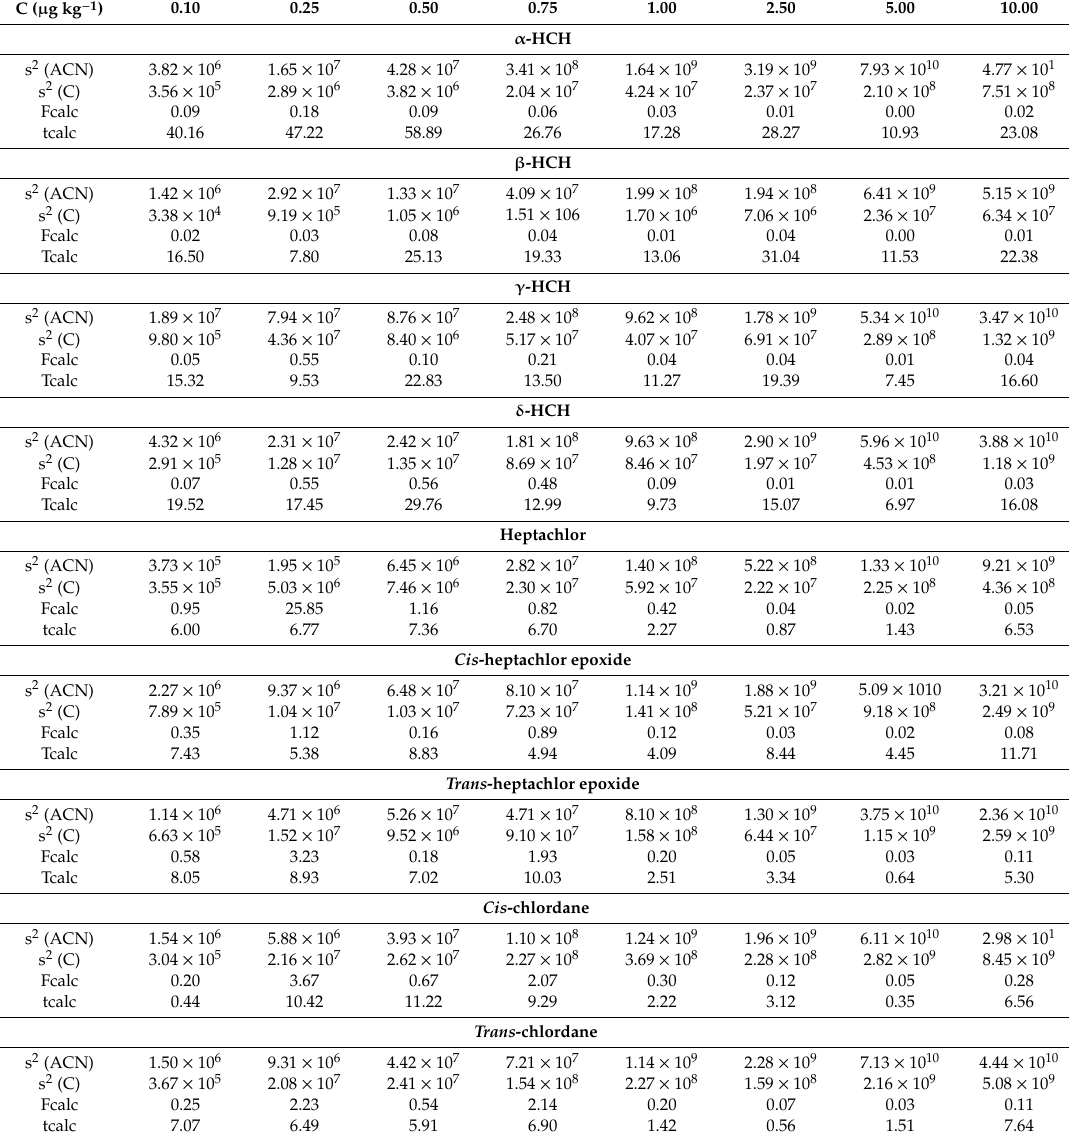
s 2 : standard deviation of the di ff erences of the replicates; Fcalc: calculated F; tcalc: calculated t; (ACN): acetonitrile; (C): Caieiras. Precision was evaluated in terms of variation coe ffi cient, repeatability and reproducibility. The variation coe ffi cient was expressed in percentage, and three concentration levels were considered, and all variation coe ffi cients were lower than 20% as observed in Table